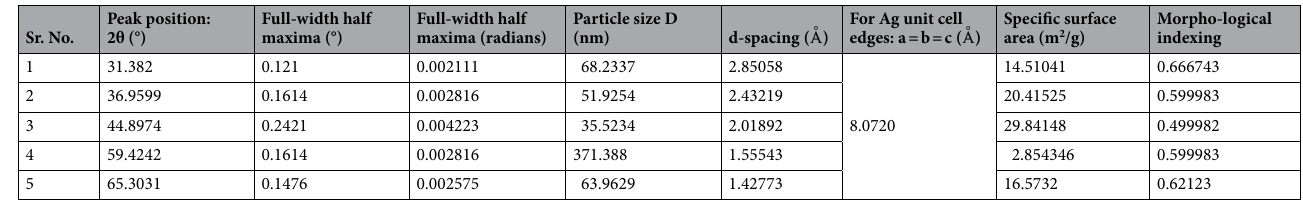
Table 1. XRD analysis and calculation of various parameters for Co 3 O 4 NPs.